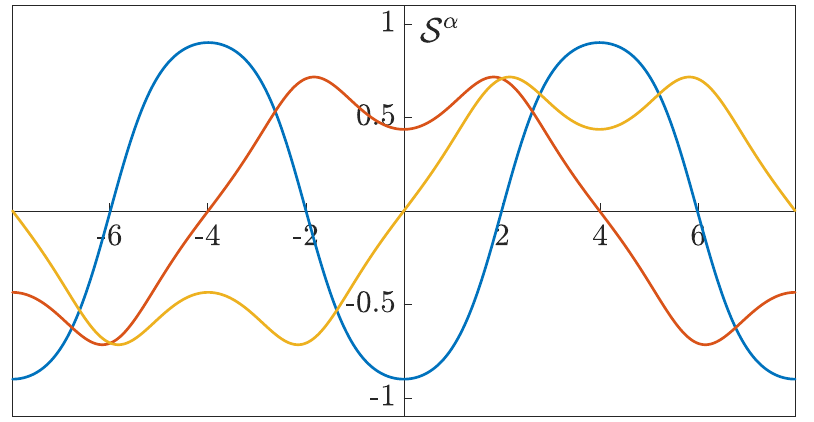
(cid:39) 1.0583559 and ξ = 0.9. Components 1 2